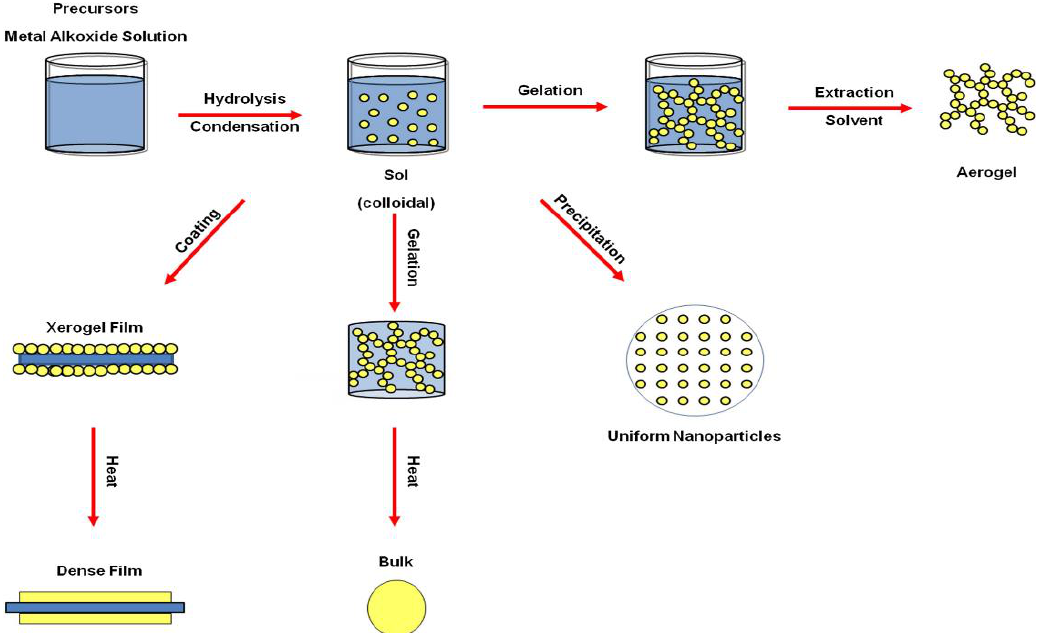
Figure 4. Different routes of the sol – gel reaction [34].